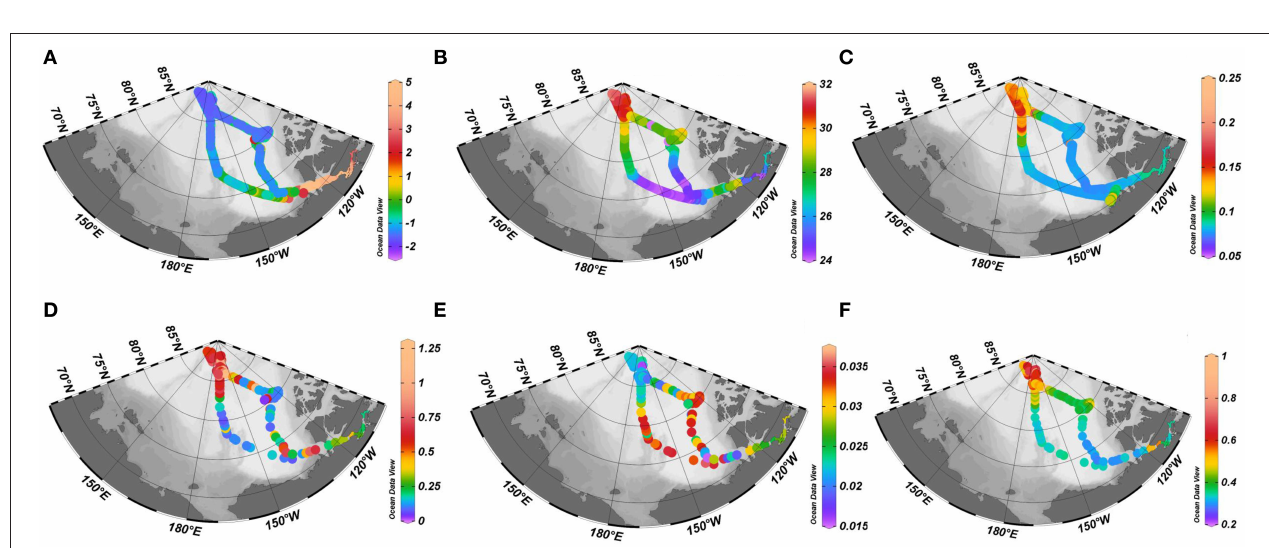
FIGURE 2 | Potential temperature ( ◦ C) and salinity (psu) from XTCD profiles along the cruise track in the top 30m (A) and 200m (B,C). The dotted lines represent the frontal zone (latitude 83 ◦ N).